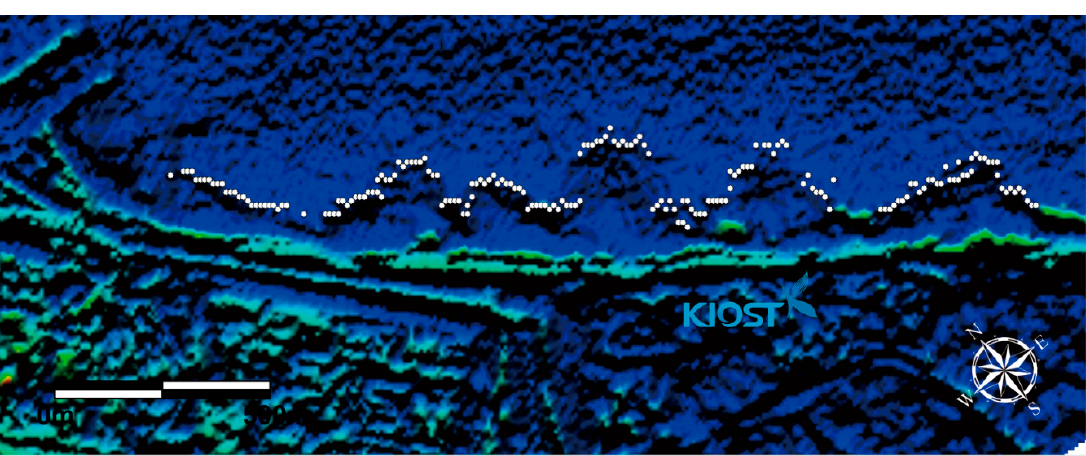
Figure 9. Converted Sentinel-II image of rater r a = b r × b g × b b on 11 December 2016 where b r , b g and b b represent the bands of red, green and blue respectively. The black dots in the sea area denote the locations of crescentic sandbar crest extracted following the algorithm by [21].